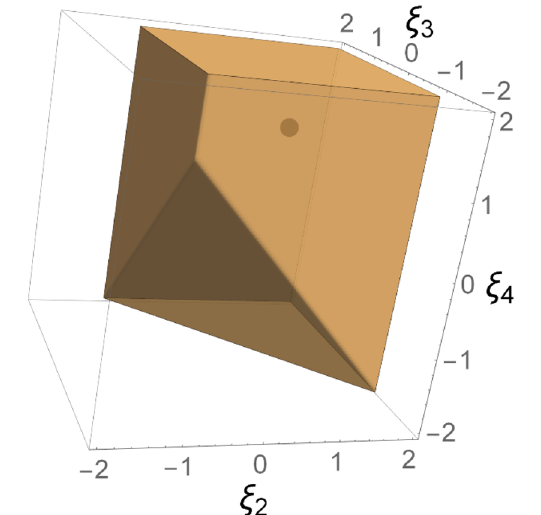
Figure 4 . Bounds on (2-u)(2-Q) operators coefficients for N f = 3 . Plots showing in yellow the allowed region obtained for the (2-u)(2-Q) operators, with generic ξ values. Here ξ have rescaled it to 1, and we show the allowed region for the remaining three. y red dot indicates the naturak MFV benchmark point, ξ the allowed